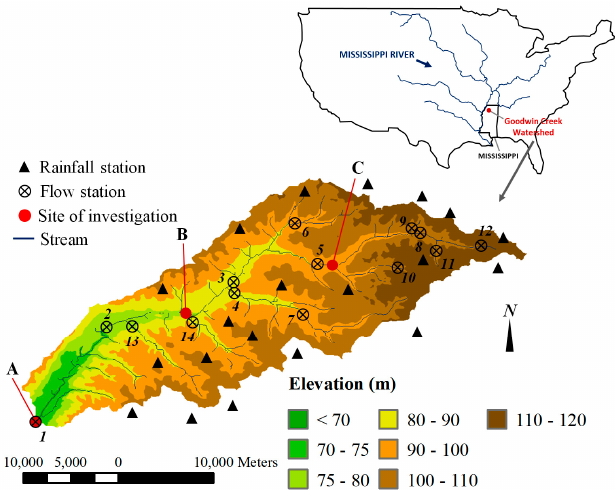
Figure 1. Geographical location and topography of the Goodwin Creek watershed. Table 1. Geomorphological conditions of the Goodwin Creek watershed.